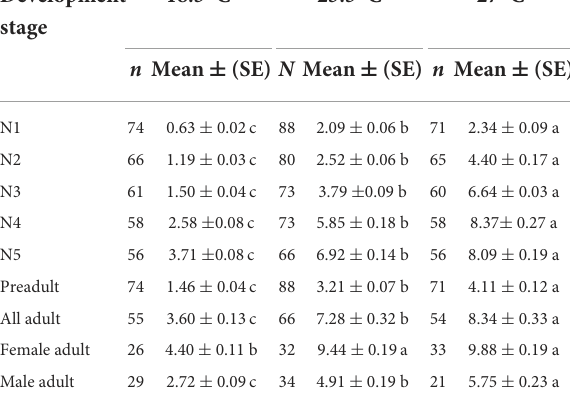
TABLE 4 Predation rate for daily ( D j ) of Orius strigicollis fed on Frankliniella occidentalis at different temperatures. Development